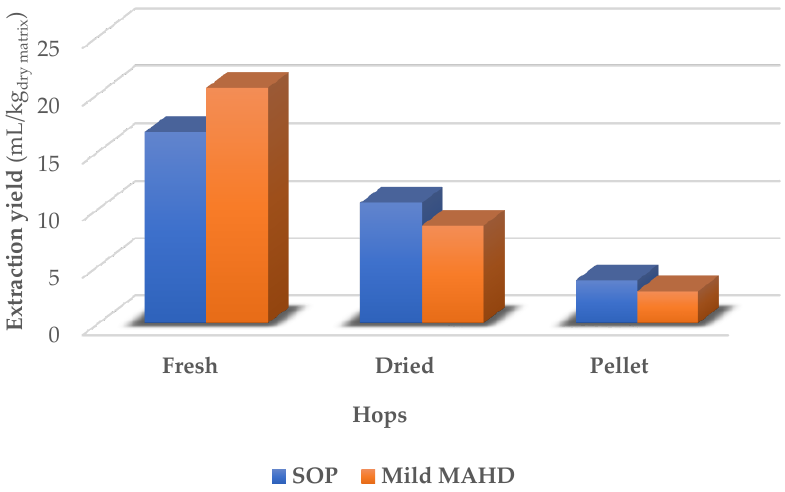
Figure 3. Volatile-fraction yield according to MAHD protocols.